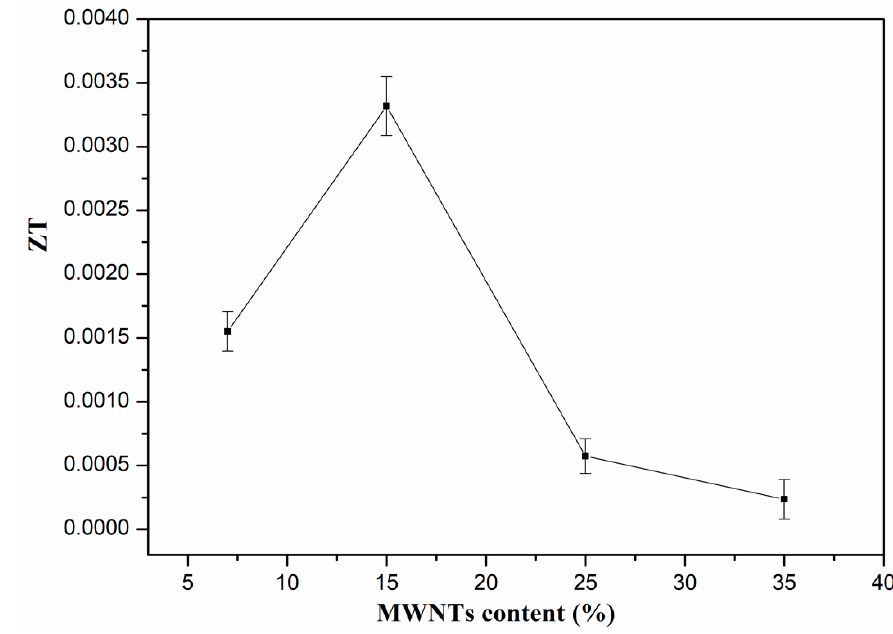
Figure 7. ZT values of PVDF composites with different content of MWNTs at room temperature. Table 2. A summary of the maximum thermoelectric performance for some typical polymer/MWNTs composites.